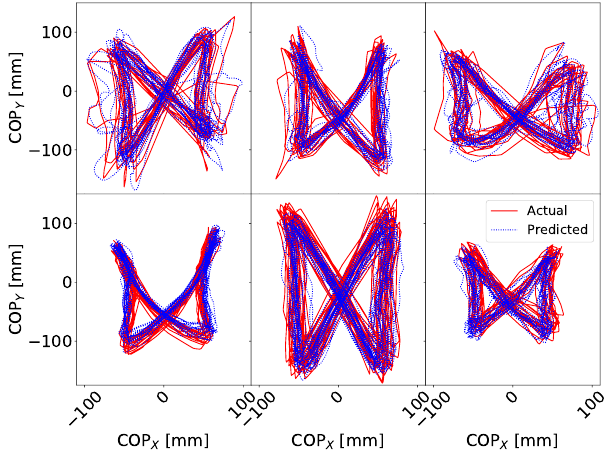
Figure 7. Gaitograms for the subjects measured in this study. Top left—S1, top middle—S2, bottom left—S3, bottom middle—S4, top right—P1, bottom